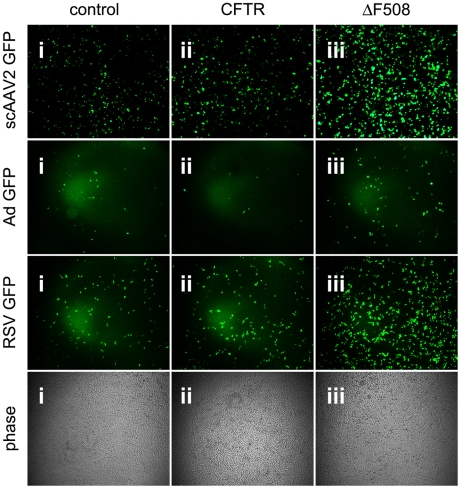
Cells expressing misfolded ΔF508-CFTR are more permissive to infection with human respiratory viruses.Images of GFP-positive cells after inoculation with recombinant self-complementary AAV (scAAV2, 100 vg/cell: eGFP transgene), adenovirus (Ad; 20 vg/cell), or respiratory syncytial virus (RSV; 200 vg/cell) into control BHK-21 cells (panel i), BHK-21 cells overexpressing CFTR (ii), or BHK-21 cells overexpressing ΔF508-CFTR (iii). Representative phase contrast images are shown to demonstrate equivalent levels of confluence.